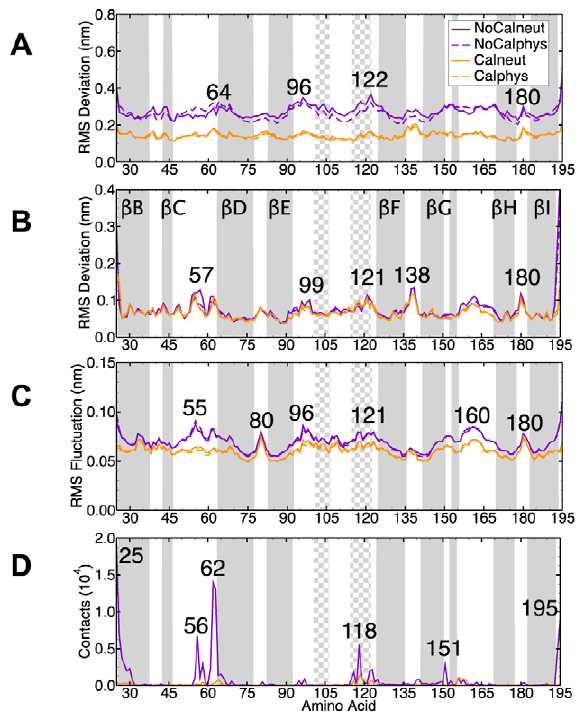
Figure 5. Structural dynamics of the capsid and water contacts. ( A ) The RMSd from the crystal structure (without over all rotation and translation of the entire capsid) for the C a of the shell domain (average over the last 0.1 m s and all 60 proteins). ( B ) As A but after aligning each protein individually to the crystal structure. ( C ) The RMSf for the C a of the shell domain (average over the last 0.1 m s ). ( D ) The number of contacts to water molecules crossing the capsid shell. The secondary structure elements of the crystal structure are shown as gray ( b -strand) or checkered ( a -helix) regions.